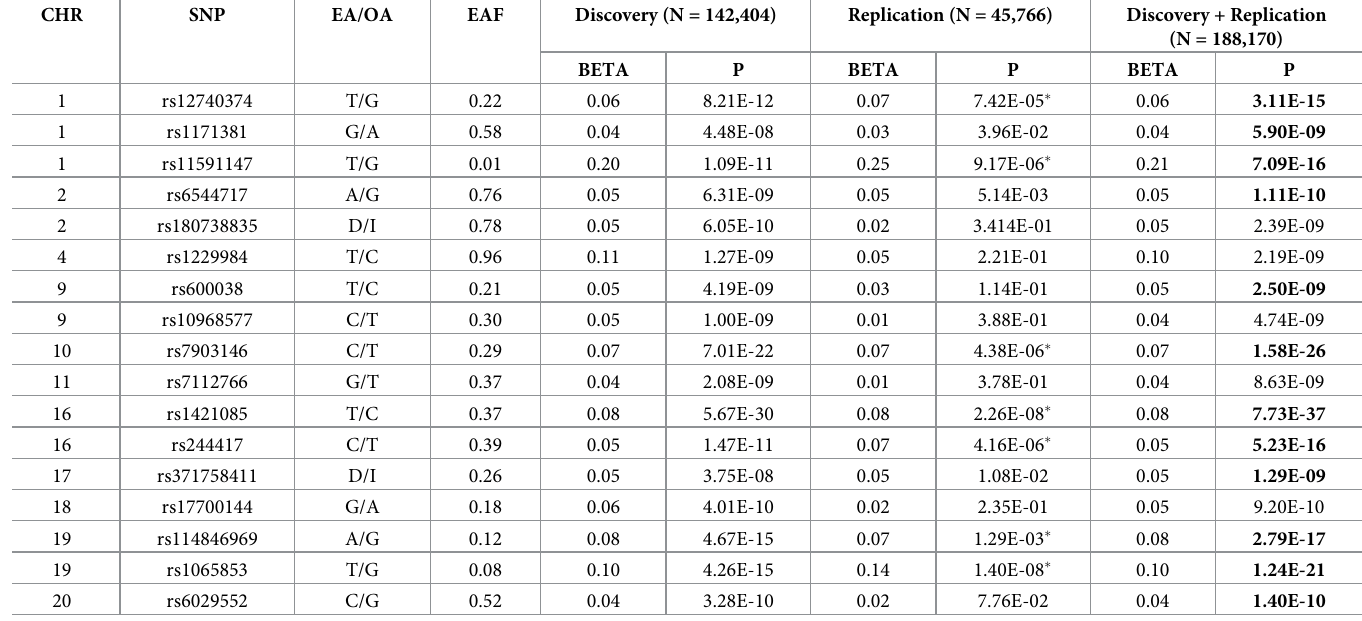
Table 3. Discovery-replication results for top 17 SNPs from the ideal health score multi-population genome-wide association